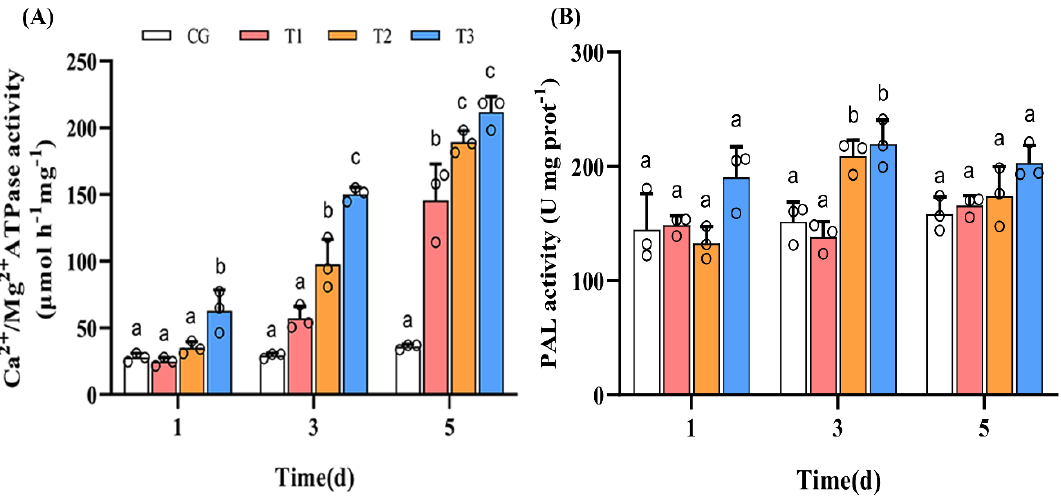
Figure 5. Changes of activities of Ca 2 + / Mg 2 + -ATPase ( A ) and PAL ( B ) for M. spicatum in each treatment on day 1, 3, and 5 (data points). CG: control group; T1: 0.1 times of original decomposing liquid; T2: 0.2 times of original decomposing liquid; T3: 0.4 times of original decomposing liquid. Di ff erent letters on top of column indicate significant di ff erences among treatments at the 0.05 significance level (Tukey HSD). Each dot represents a replicate.